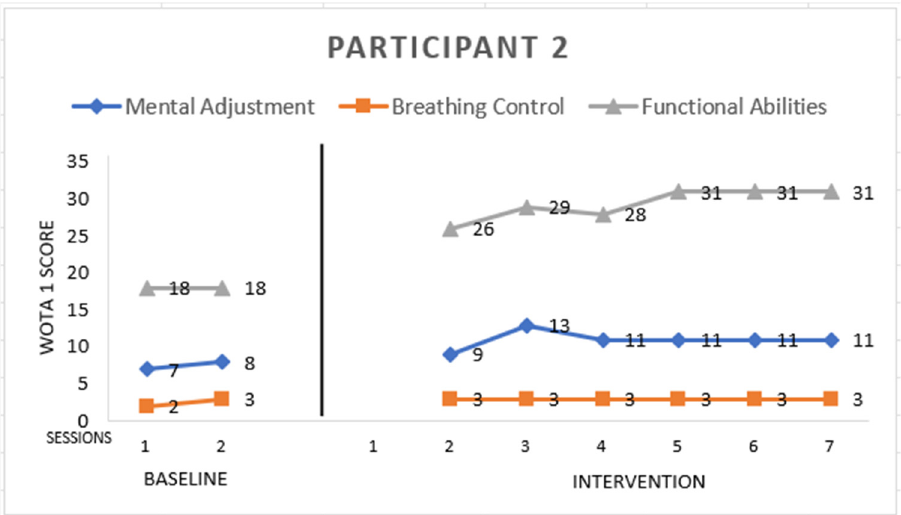
Figure 2. Highest possible scores: Mental Adjustment = 16, Breathing Control = 8, Functional Abilities = 36.